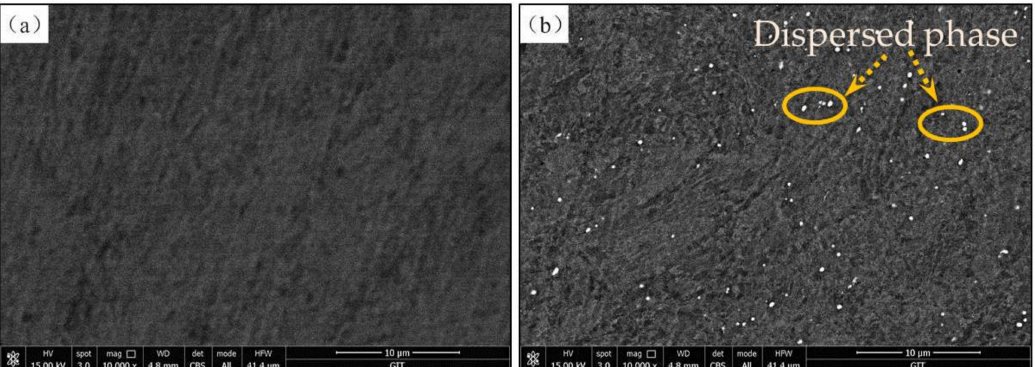
Figure 2. Scanning electron microscopy equipped with a backscattered electron (SEM–BSE) of the M50NiL steel samples with coarse and fine grains prior to deformation: ( a ) coarse-grained sample; ( b ) fine-grained